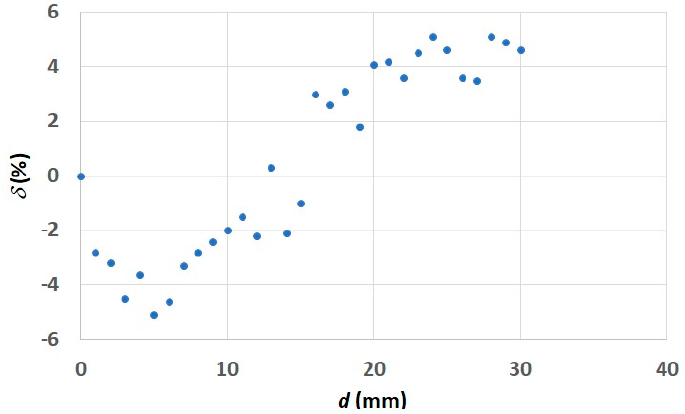
Figure 8. Dependence of the error δ as a function of the distance between the lens and the observed object d .